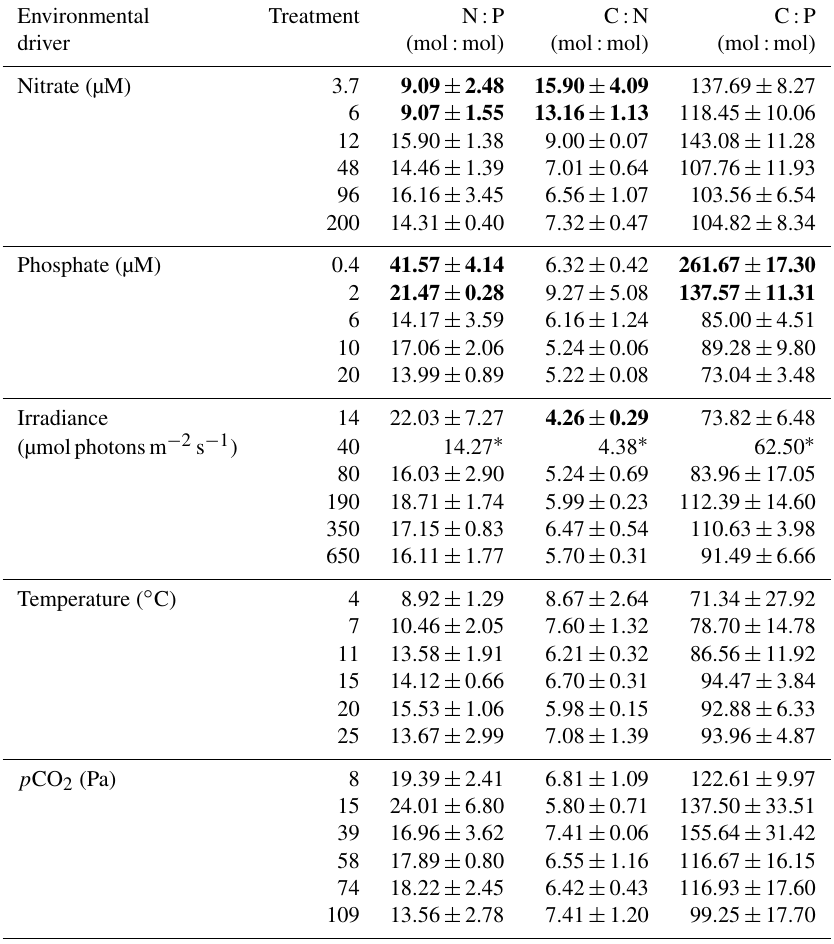
Table 2. Elemental molar ratios of N:P, C:N and C:P of Emiliania huxleyi from the five single-factorial manipulation experiments. The errors are standard deviations around the mean ( n = 3). The values in bold are significantly different compared to other